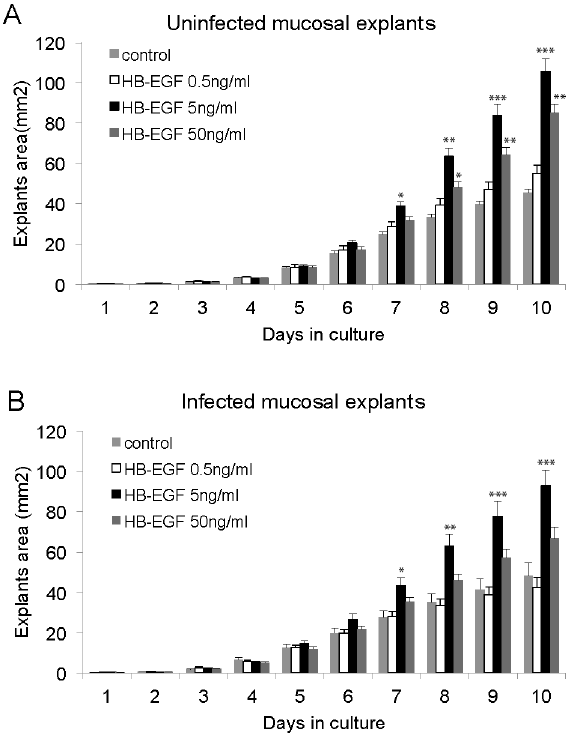
Figure 3. Daily change in surface area of mucosal explants with administration of rHB-EGF. ( A ) Uninfected mucosal explants were cultured in the presence of various concentrations of rHB-EGF (0.5, 5, or 50 ng/ml). A negative control without rHB-EGF was identically treated. ( B ) Infected mucosal explants which were harvested 48 h after bacterial inoculation were cultured in the presence of various concentrations of rHB-EGF (0.5, 5, or 50 ng/mL), or in unsupplemented media (control). Values are means 6 standard errors (SE) (n=12 at each group).